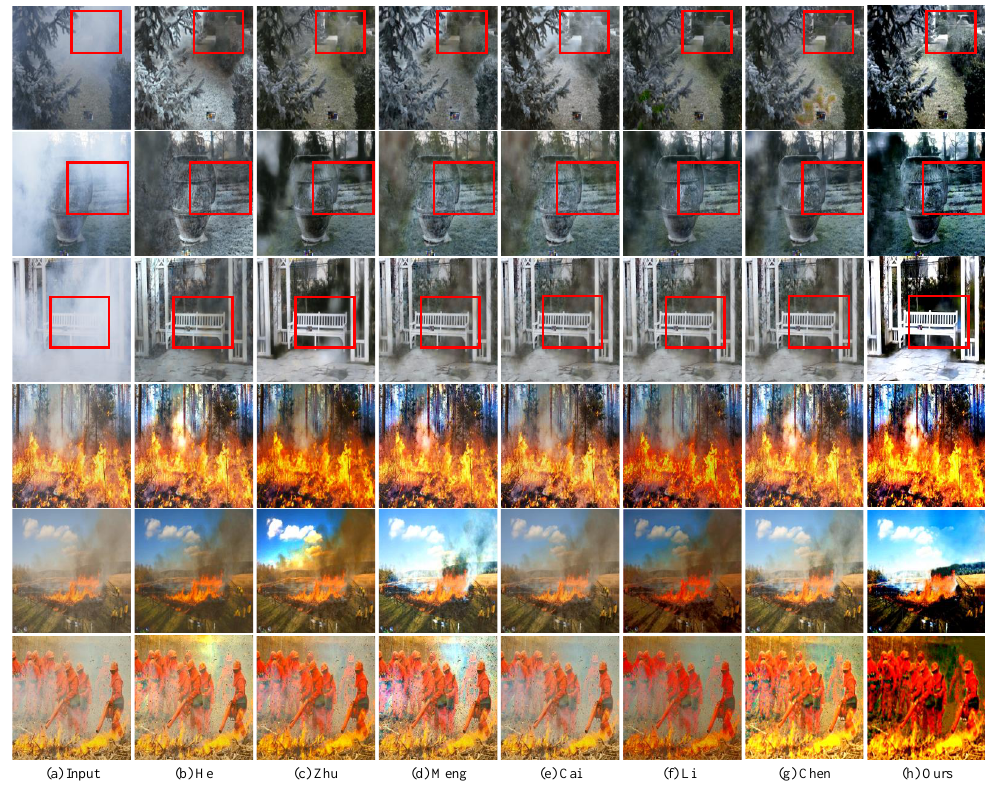
Figure 7. Visual comparisons on real-world images. The proposed method can effectively enhance the quality of different real-world hazy images with naturalness